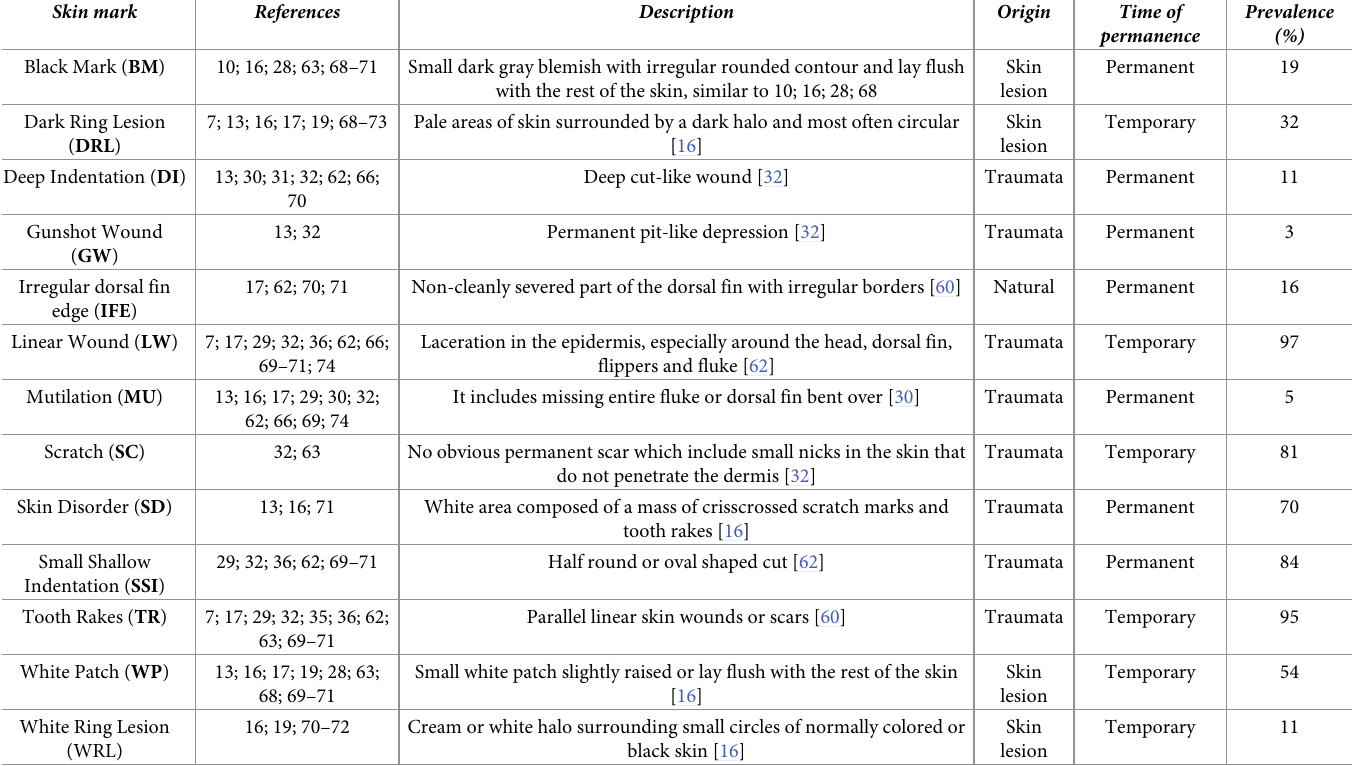
Table 1. Skin marks types found in bottlenose dolphins from Aeolian Archipelago. The scientific papers that previously described skin marks and a brief description as these appeared in photographs are reported in the second and third columns of the table. Classification of skin marks types according to the origin, time of permanence on the dolphins’ bodies and their prevalence in the population (%) are also reported in the other